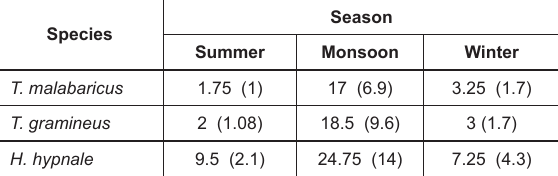
Table 4. Variation in the observation of pit vipers among different seasons in the Western Ghats of Goa (Mean ±